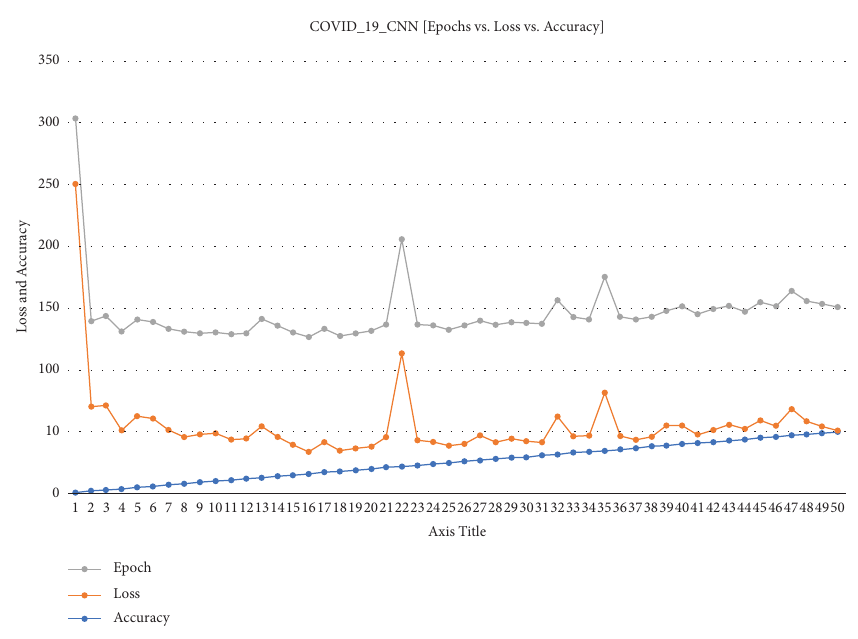
Figure 2: COVID-19 ECNN graph comparing epoch vs. loss vs.